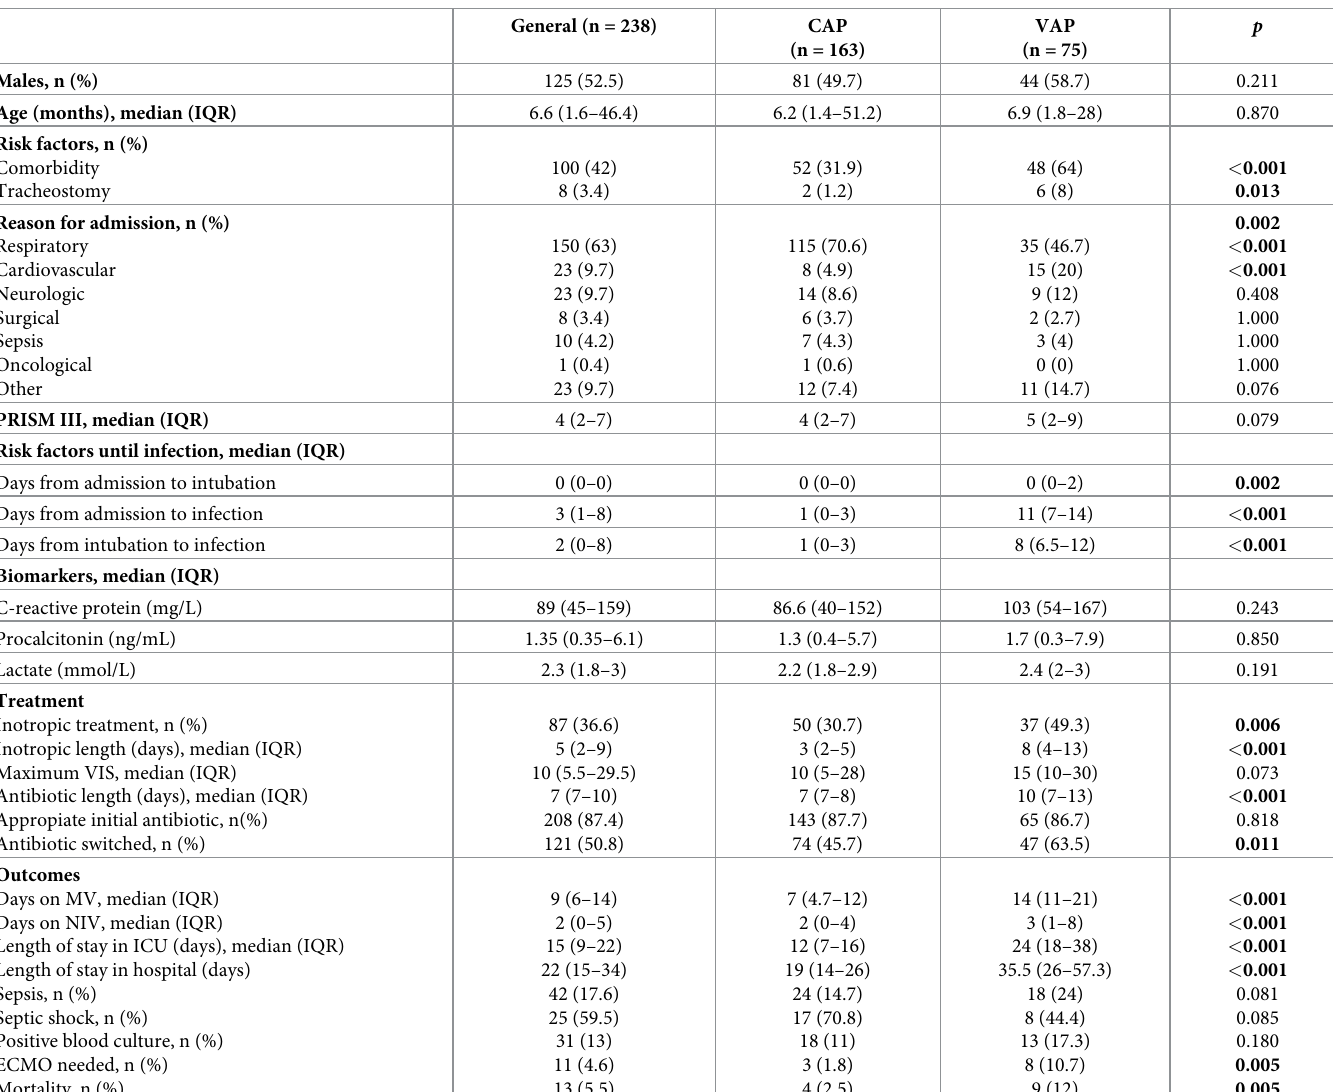
Table 1. Patient characteristics, risk factors, and